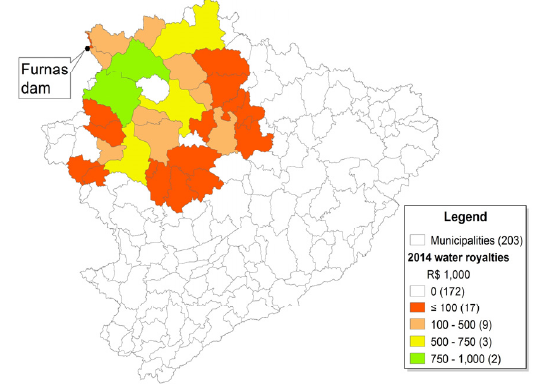
Figure 4. Spatial distribution of water royalties paid in 2014 to the municipalities within Furnas watershed.